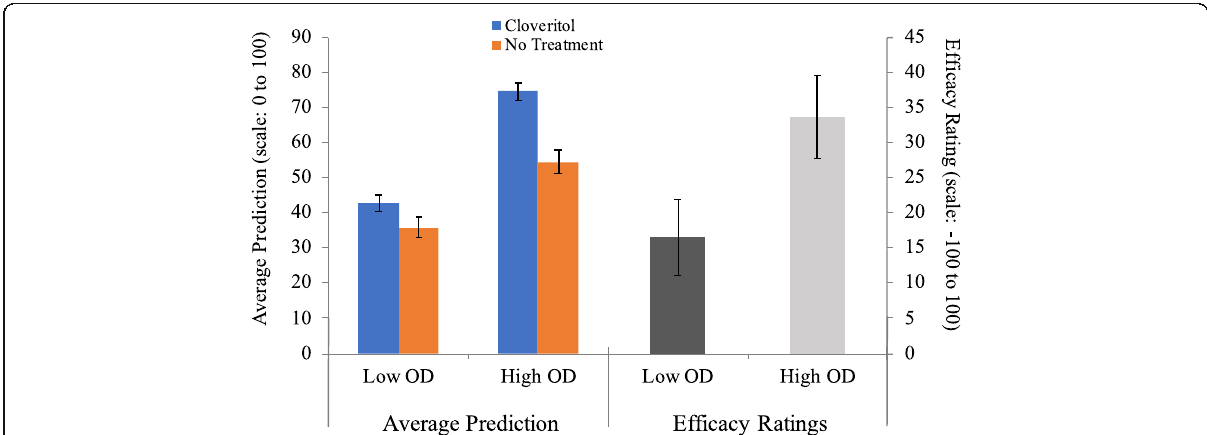
Fig. 5 Average prediction for Cloveritol and no treatment at test (± standard error of the mean) (left) and efficacy ratings for treatment relative to no treatment (right) as a function of outcome density. Average predictions were made on a scale from 0 (no improvement) to 100 (full recovery), whereas efficacy ratings were made from a scale of − 100 (effectively worsens recovery) to +100 (effectively improves recovery) with a midpoint of 0 (completely ineffective). Negative efficacy ratings indicate that the drug makes patients feel worse, whereas positive values suggest the drug improves patient recovery. OD outcome